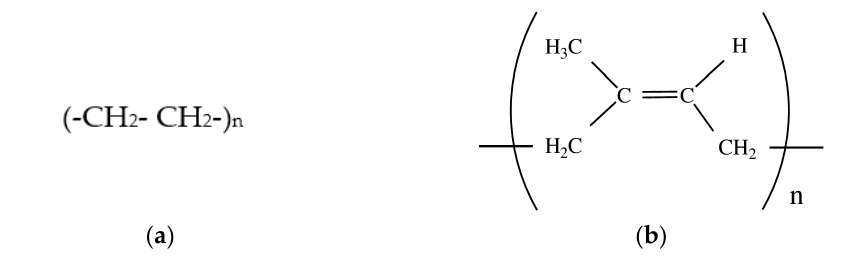
Table 1. Compositions of the LDPE/NR blends.